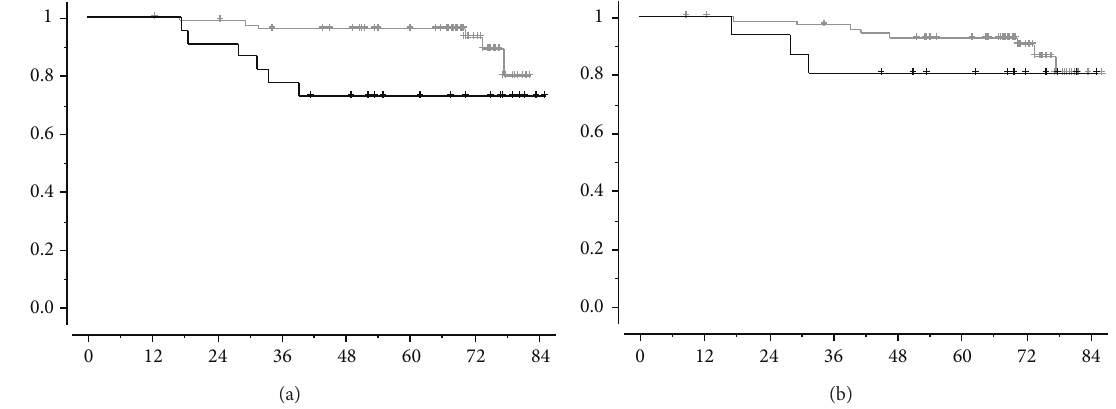
Figure 2: Overall survival, OS according to CTC detection before neoadjuvant chemotherapy ((a), 𝑃 = 0.03 ) or after neoadjuvant chemotherapy ((b), 𝑃 = 0.30 ). Black lines correspond to patients with ≥ 1 CTC/7.5mL and grey lines to patients with no CTC detected.